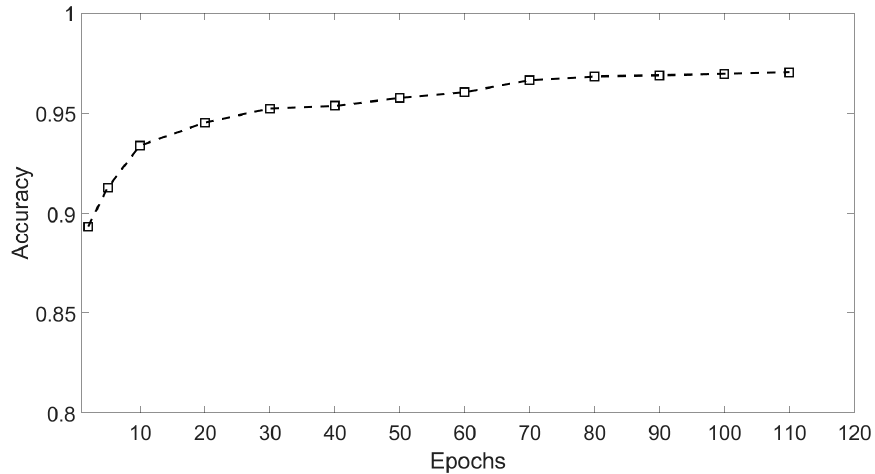
Figure 11. Results of different epochs.